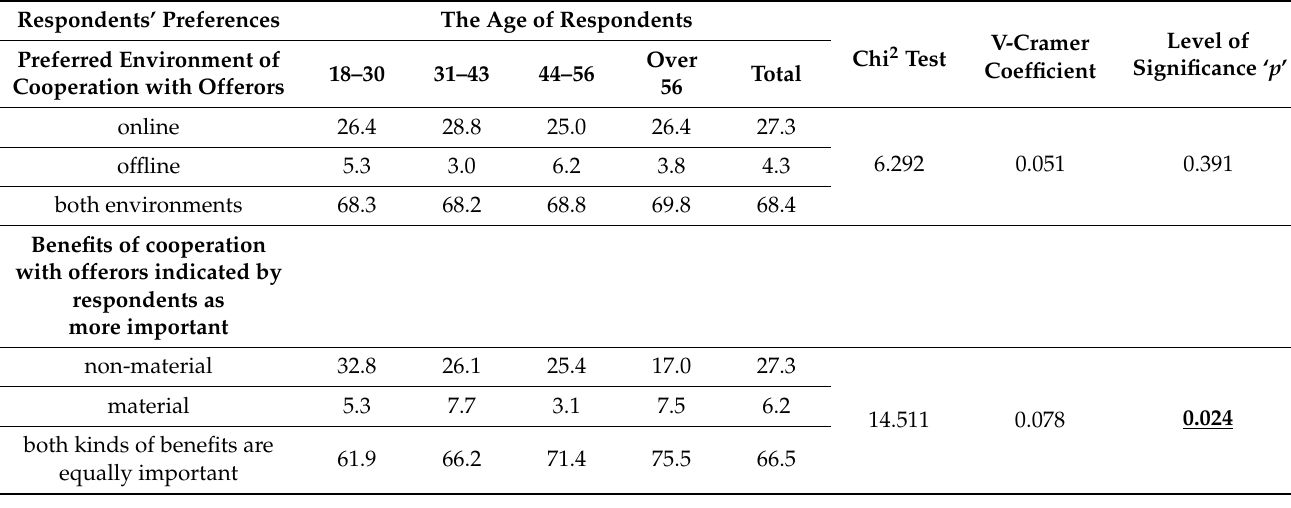
Table 7. Specific benefits indicated by respondents that a final purchaser achieves thanks to cooperation with offerors versus respondents’